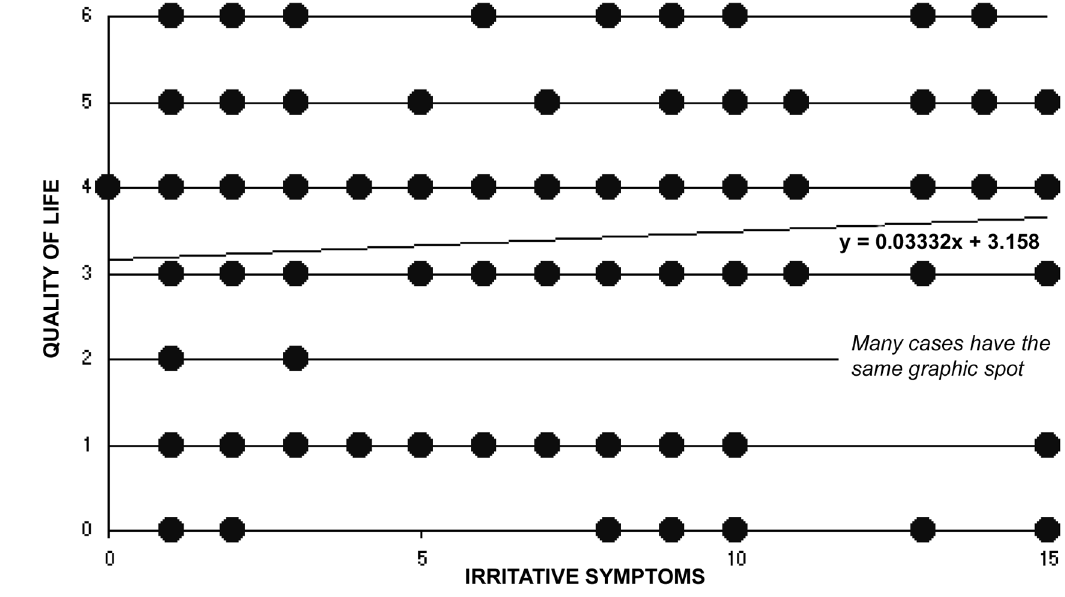
Figure 3 – Correlation between irritative symptoms and quality of life in 400